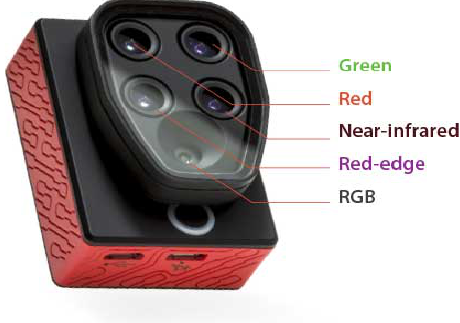
Figure 2. Parrot Sequoia Multispectral sensor